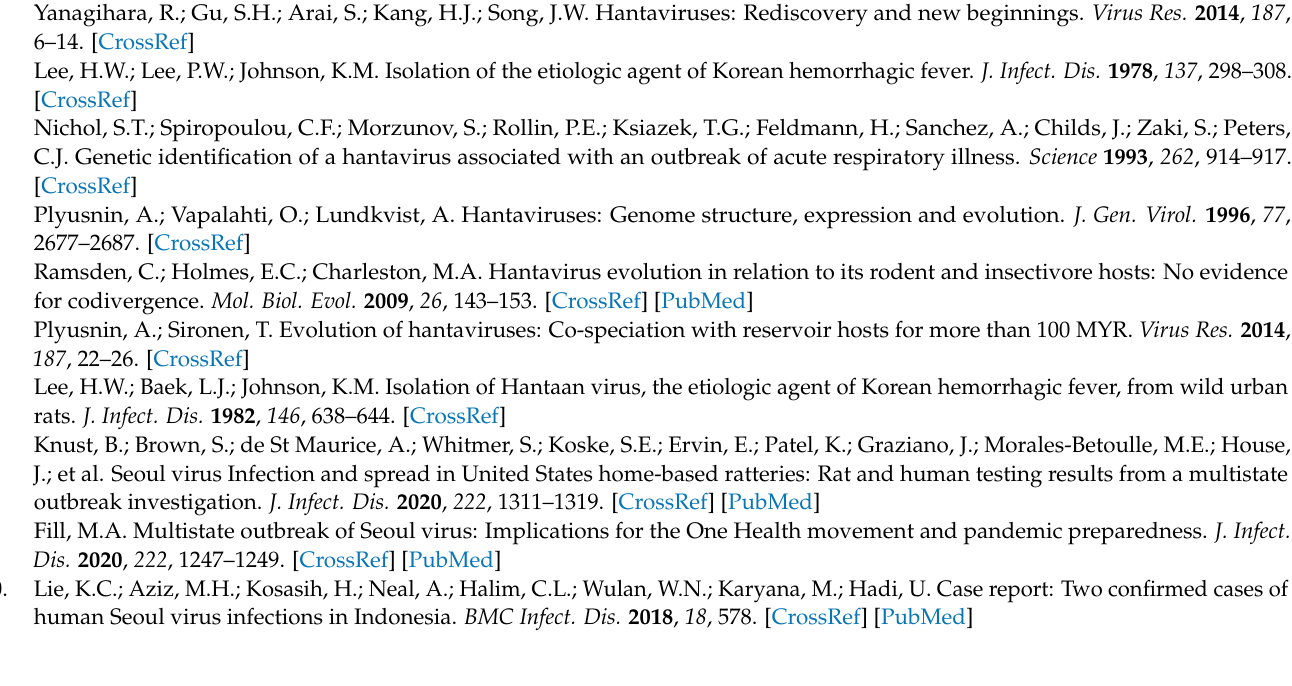
Table S2: SEOV genome detection from sera of IgG-positive rats. Figure S1: Sample collection from rats inoculated with SEOV SR-11. Figure S2: Primers and a probe for quantification of viral RNA used in this study. Figure S3: ELISA ODs of IgM and IgG antibodies in all rats inoculated with